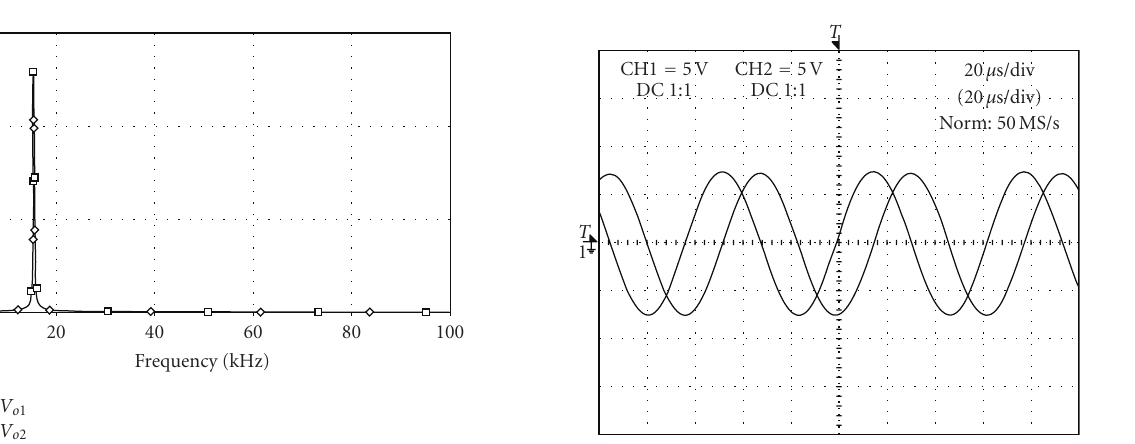
Figure 9: Simulated frequency spectrums of the proposed oscillator of Figure 4.